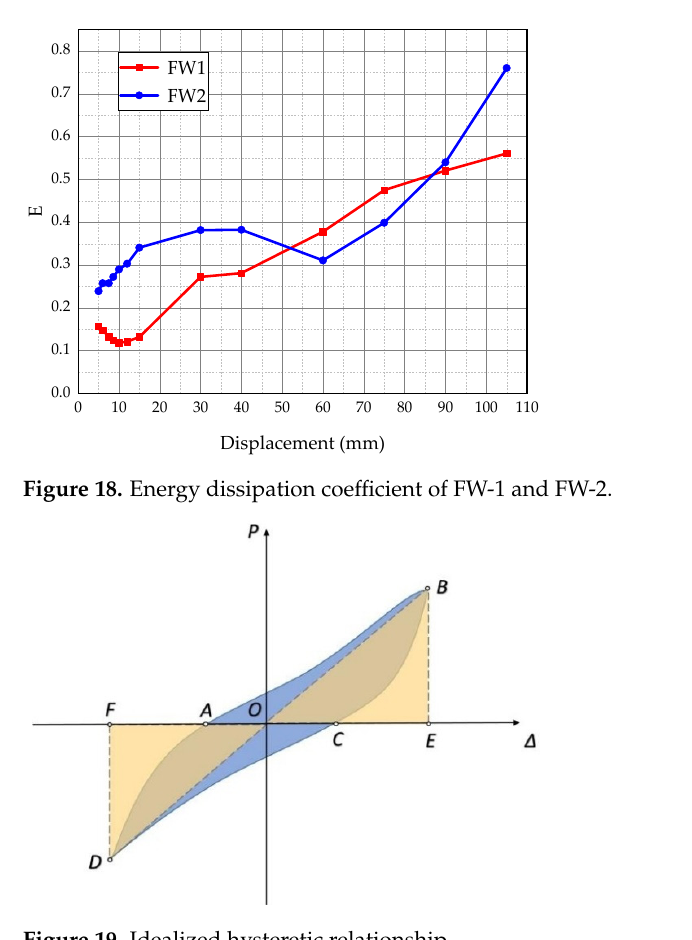
Figure 19. Idealized hysteretic relationship.